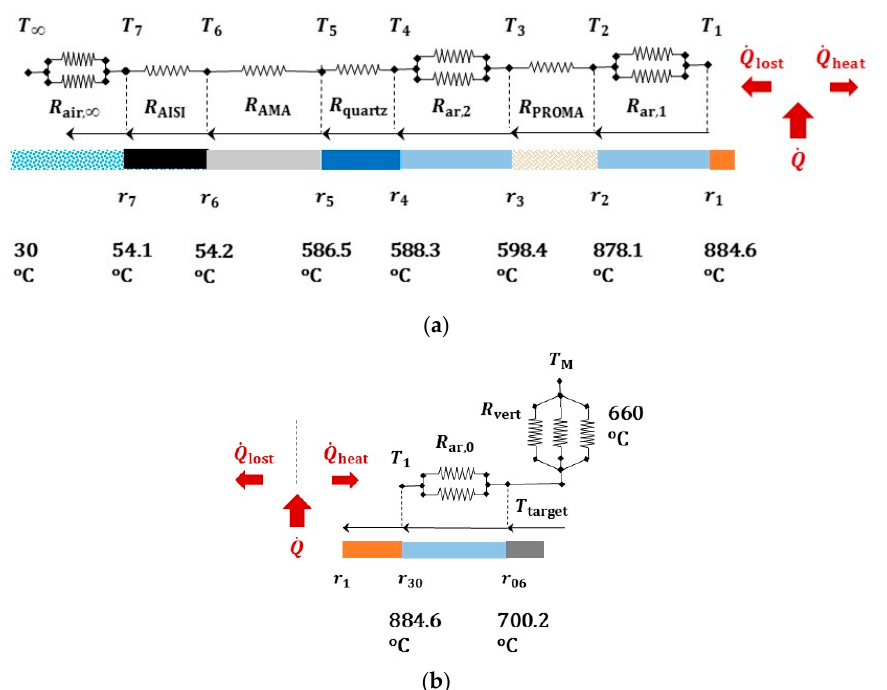
Figure 12. Steady state temperatures along the radius of the furnace (not in scale), predicted by the thermal resistance method for a generated power Q = 60 W, and prescribed temperatures at the ends ( T ∞ of the environmental air and droplet melting temperature T M ). With respect to the heating element at the temperature T 1 , scheme in ( a ) concerns the outer layers, that in ( b ) the inner ones. The subscripts ar and air denote argon and air properties, respectively.